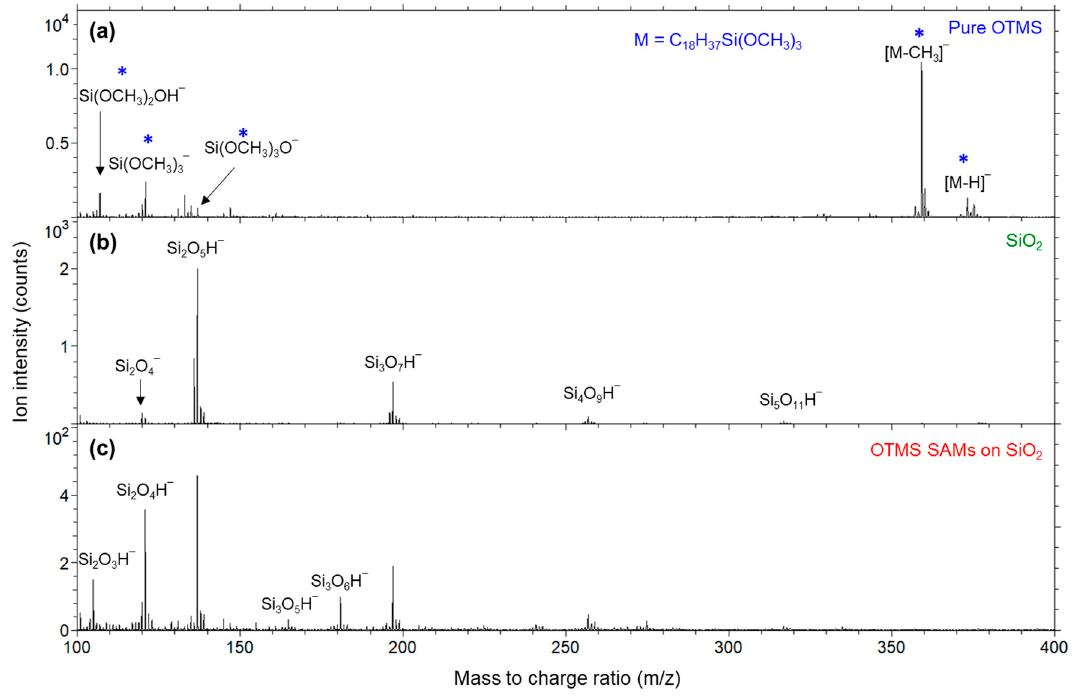
Figure 6. Negative secondary ion mass spectra ( m / z 100–400) for ( a ) pure OTMS (placed on a polypropylene film); ( b ) a UV/ozone-treated SiO 2 substrate; ( c ) OTMS SAMs prepared on a UV/ozone treated SiO 2 substrate. Ions indicated by a star (*) are associated with the OTMS headgroup, ‒Si(OCH 3 ) 3 .